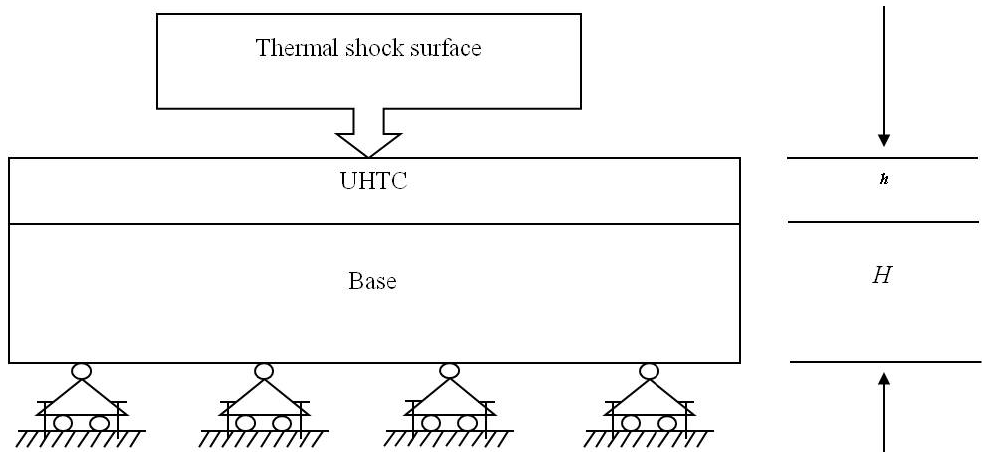
Figure 1. The geometric